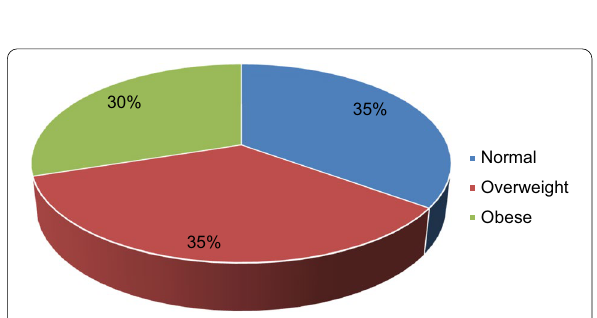
Fig. 2 Body mass index categories